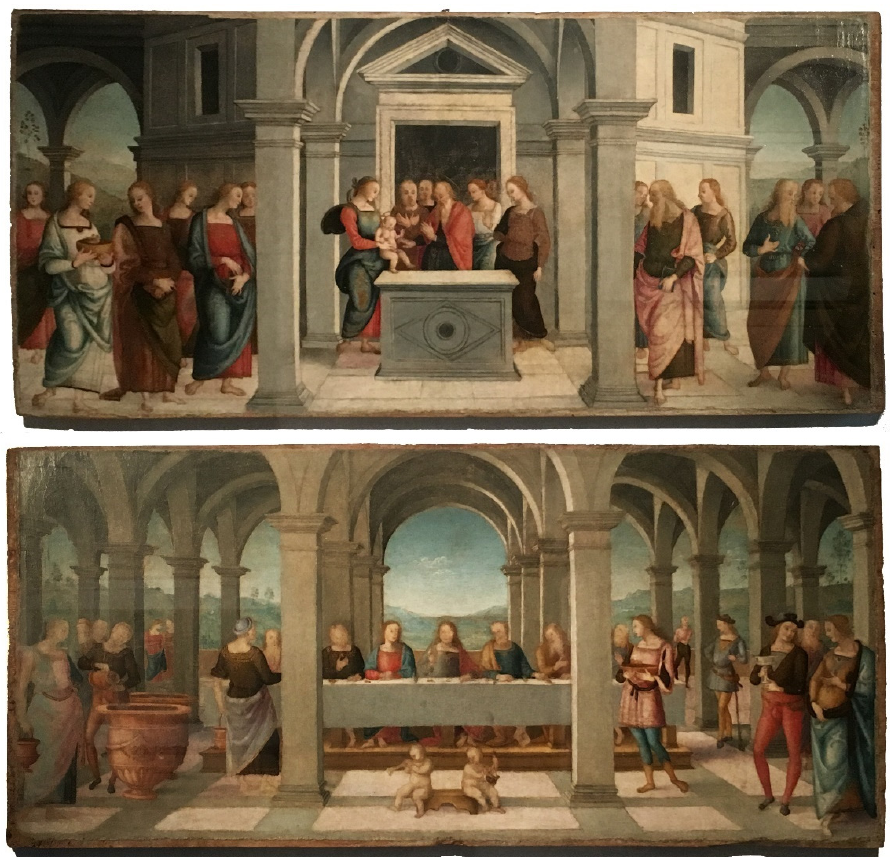
Figure 4. Pietro Vannucci known as Perugino (and Raffaello?), Polyptyc of St. Augustin, 1502–1523, Galleria Nazionale, Perugia: The Presentation to the Temple ( above ); The Marriage at Cana ( below ). Raffaello also had the opportunity to develop his architectural models on behalf of the Sienese Bernardino di Betto Betti, known as Pinturicchio (1452–1513), another of Perugino’s pupils. The fresco cycle of the Piccolomini Library, Siena, was designed in a rectangular hall as a sequence of 12 huge ‘windows’ (4 on the longer sides and 2 on the shorter ones). Except two real windows, the others are virtual openings on painted scenes of remote places. While the architectural pillars and arches that separate the ‘windows’ are depicted in perspective with the horizon line at the eye level in order to suggest an illusory expansion of the hall, the painted scenes inside them present a higher horizon line, accentuating the effect of detachment and movement from different realities. The pseudo-basilica building on a seven-step plinth depicted in The Coronation of Enea Silvio Piccolomini , which Frommel attributes to Raffaello, represents the Imperial Palace in Aachen, Germany, where the coronation took place. At the same time, it recalls one of the hypostyle halls painted by Perugino seen from the outside (Figure 5). The ground floor presents five naves with three deep bays. The cross vaults set on round arches rest on pillars, while bands of the white stone border the floor squares. Despite being conceived for a painting, the painter designed it as an architect would do: he reduced all the elements to simple proportions, used cross-shape pillars to support the vaults better; added volutes to bear the lateral thrusts of the upper barrel vault; showed the first steps of a staircase.